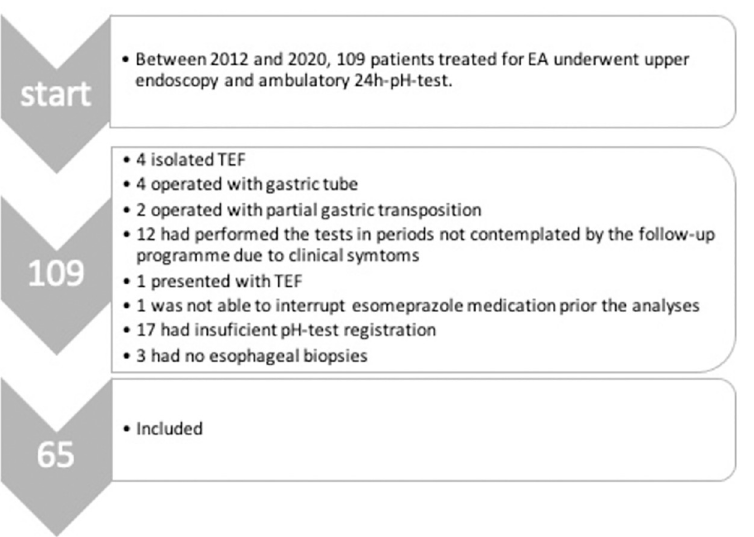
Fig 1. Flow chart of the patient inclusion